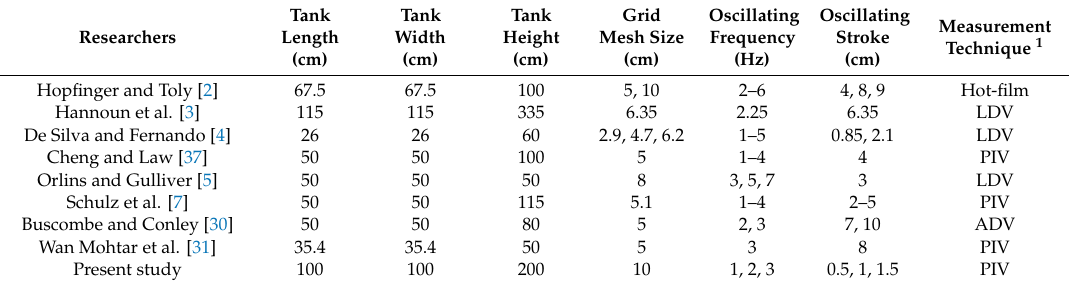
Table 1. Experimental details of oscillating grid turbulence (OGT) in the previous studies.